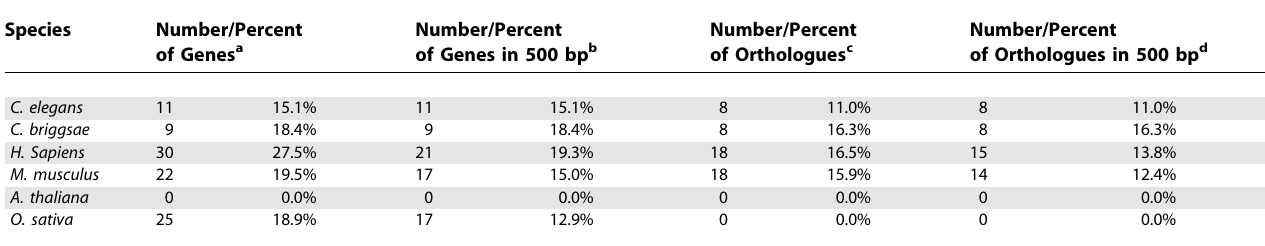
Table 9. Putative CpG Islands in the Upstream Regions of Corresponding Hairpinned pre-MicroRNAs